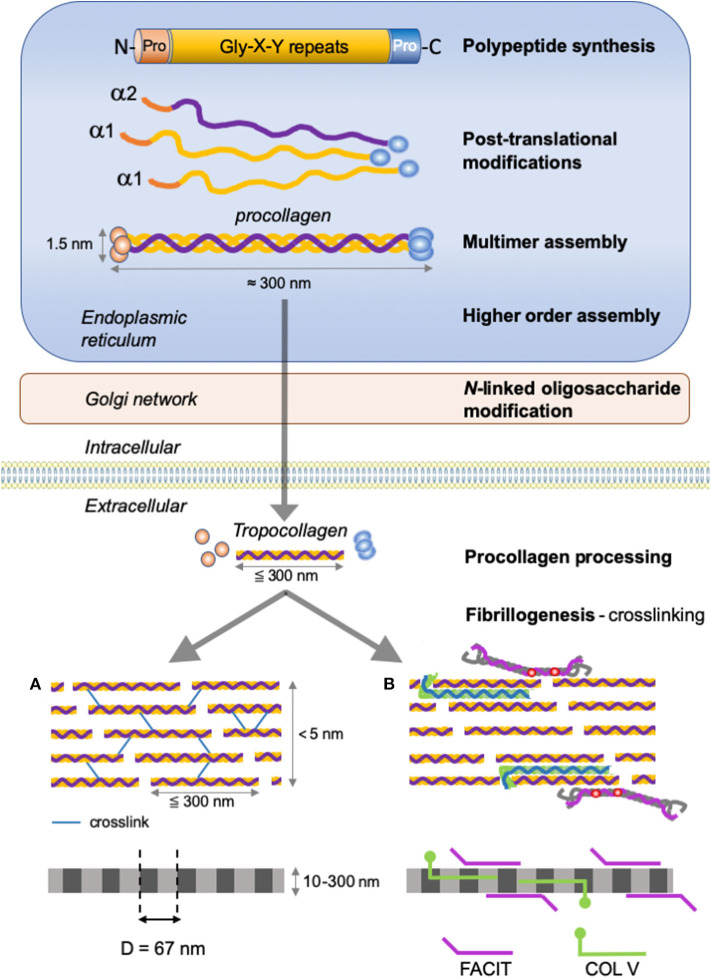
Type I collagen supramolecular assembly pathway. The standard fibrillar collagen molecule is characterized by N- and C-terminal propeptide sequences, which flank a series of Gly-X-Y repeats (where X and Y represent any amino acids but are frequently proline and hydroxyproline). These form the central triple helical structure of procollagen and collagen. Three precursor α-chains (two α1 and one α2) are co-translationally translocated into the endoplasmic reticulum lumen, where specific post-translational modifications occur. Three collagen α-chains associate specifically via their C-terminal domains to form heterotrimers. The helical collagens are trafficked via the Golgi network to the plasma membrane, and secreted into the extracellular space as precursor forms, called procollagens, with N- and C-terminal non-collagenous domains. These domains are removed by the action of specific proteases, and the collagens are assembled into dense fibrils with a characteristic D-periodicity of about 67 nm (A). The fibril is stabilized by covalent lysine- and hydroxylysine-derived crosslinks. In addition to fibrillar collagen, other collagens, such as type V and FACIT collagens, are incorporated into the fibril structure (B). Type V collagen is inserted between strands of the microfibril, and FACIT collagens cling to the surface of the microfibril and work to stabilize higher order structures. Adapted from (38).